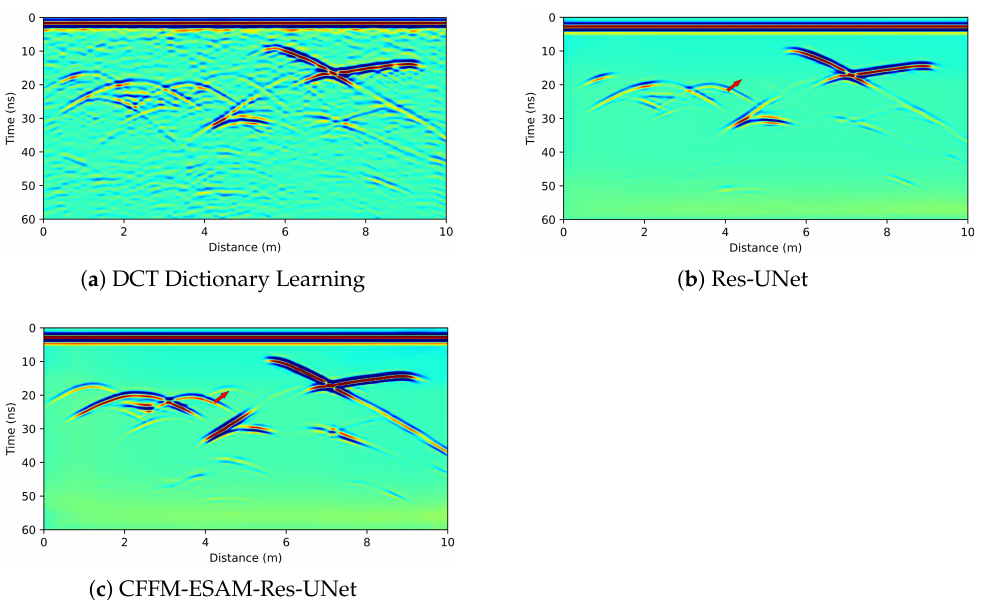
Figure 10. Synthetic-GPR-recording clutter-removal results for three